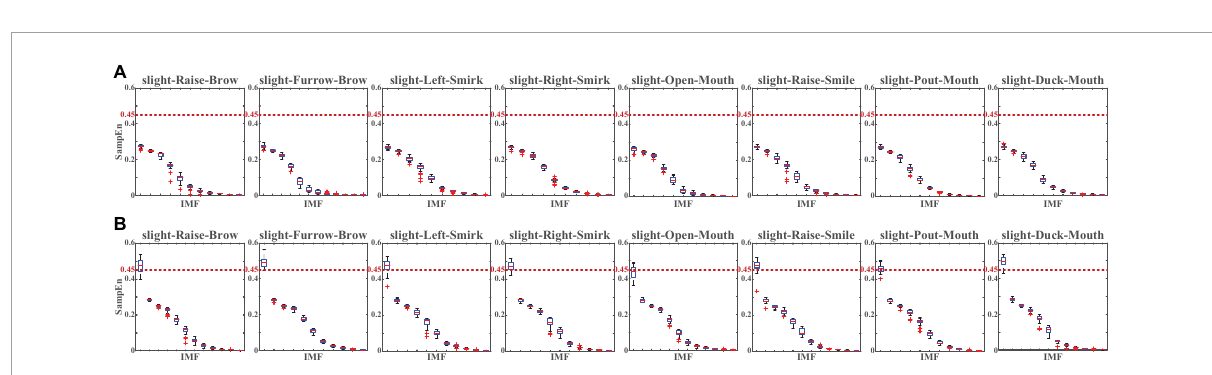
FIGURE11 The SampEn of intrinsic mode functions (IMFs) decomposed from the slight-facial expression (sFEs)-electroencephalograms (EEGs) with (A) passband (5 Hz, 50 Hz) and (B) passband (5 Hz, 95 Hz). The red dash line represents the 0.45